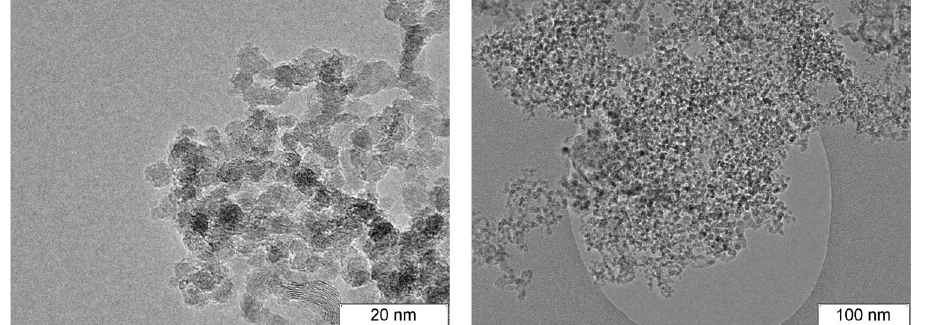
Figure 2. Carbon residuum of TNT/RDX 50/50 detonation.